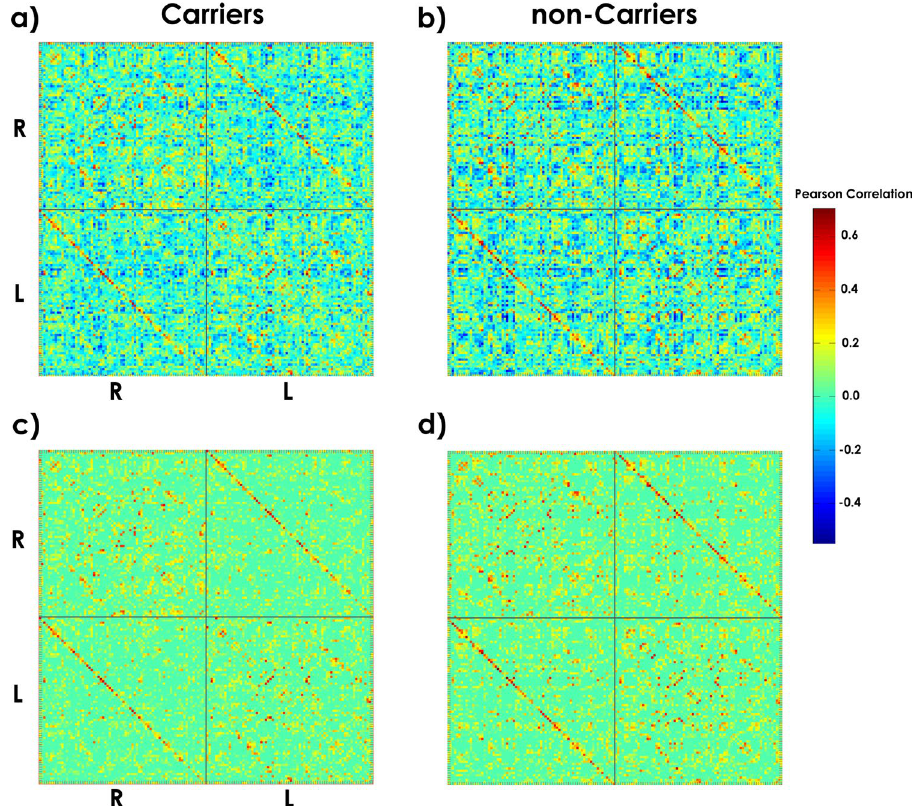
Figure 3. Cortical thickness correlation matrices for each group. ( a ) and ( b ) display matrices with positive and negative correlation values. ( c ) and ( d ) represent matrices with positive correlation values. The strength of the connection is indicated by the color bar. The ’R-’R’ and ’L-’L’ quadrants represent the intra-hemispheric cortical thickness correlations in the right and left hemispheres. The ’R-’L’ and ’L-’R’ quadrants depict